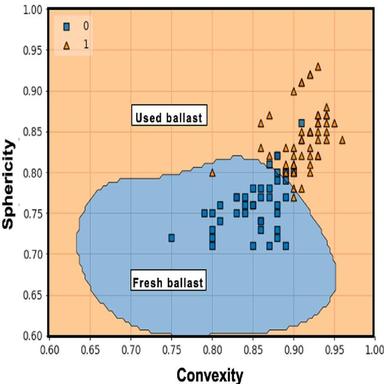
The scope of fresh and used ballast was obtained by the SVC method.